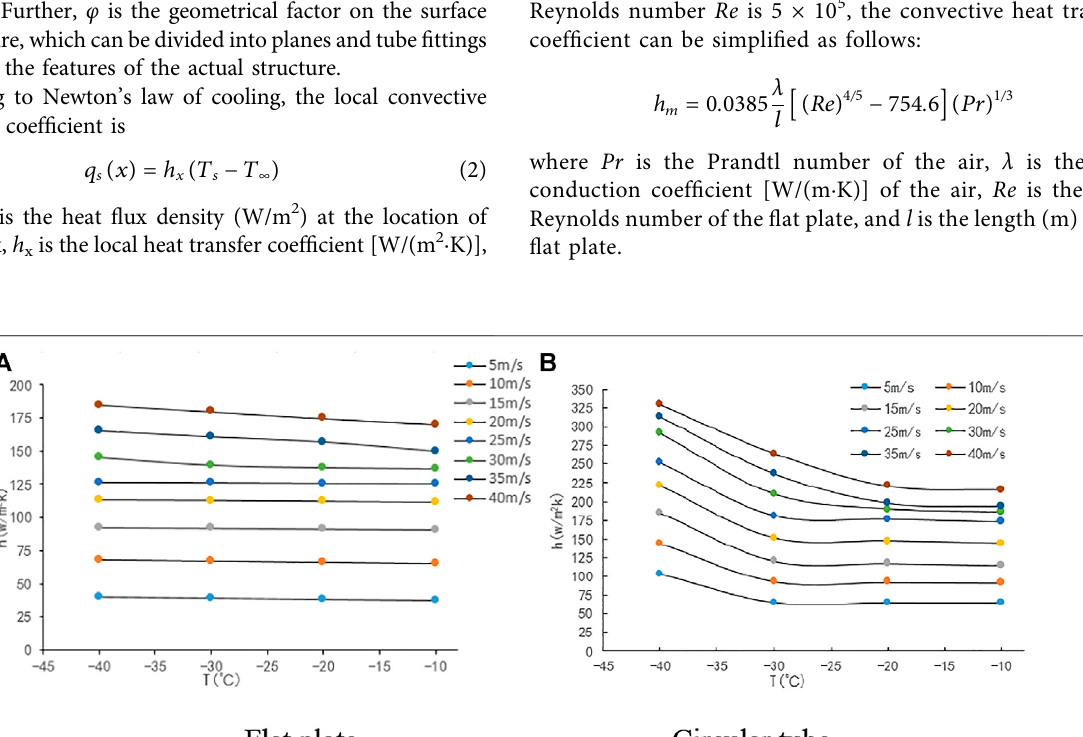
Frontiers in Energy Research |